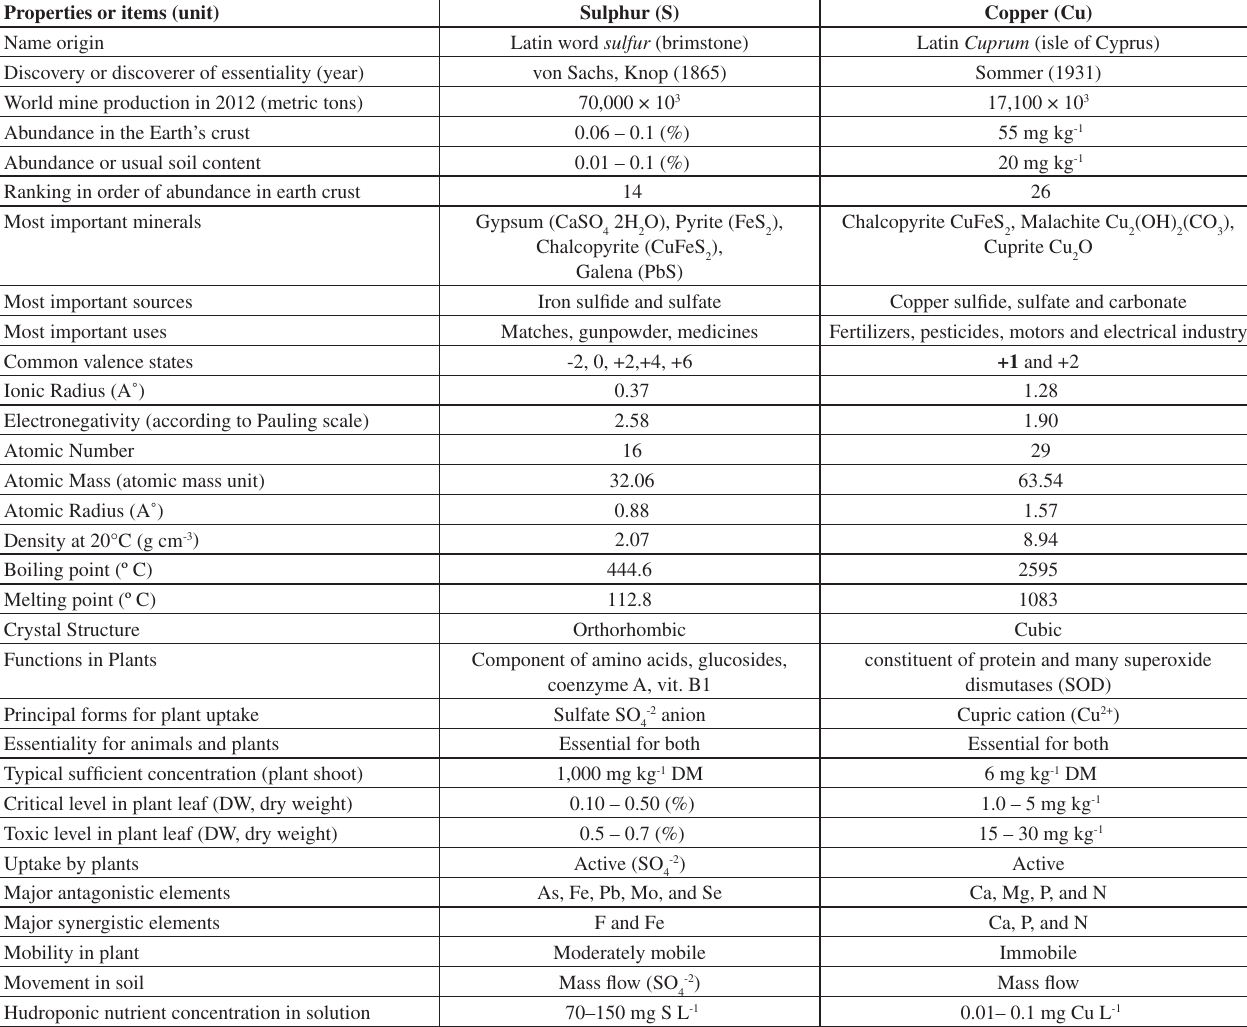
Table 4: Selected properties of copper comparing with sulfur as an element-based fungicides for some physical, chemical and biological properties Properties or items